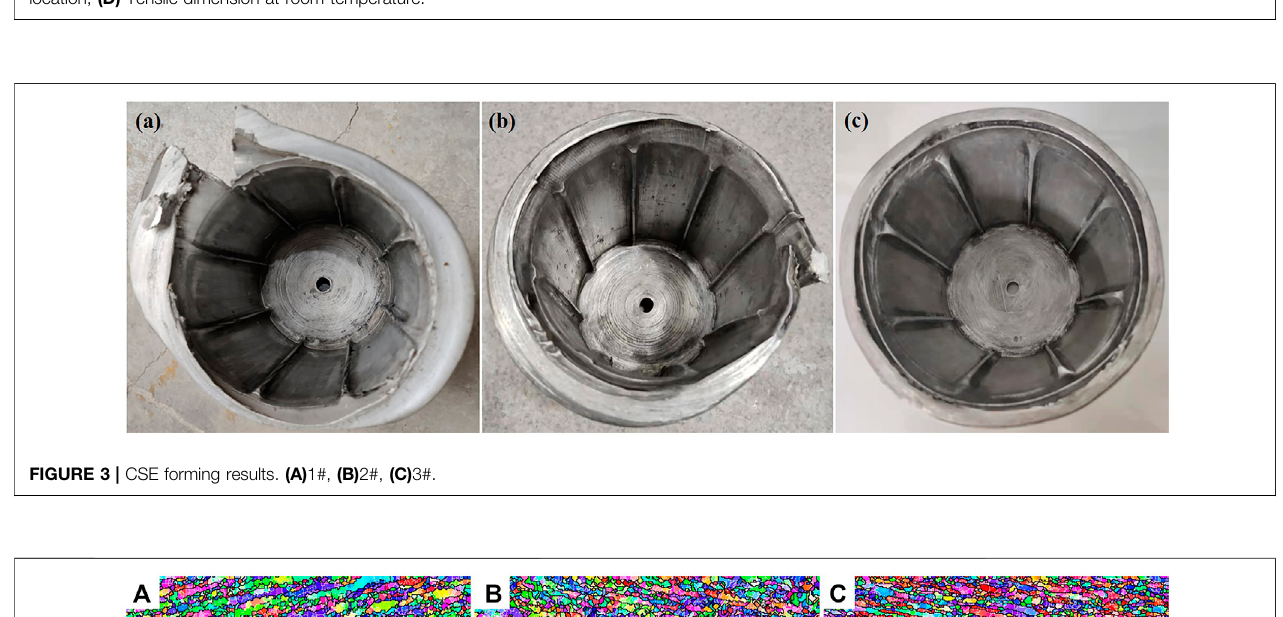
FIGURE 2 | CSE forming schematic diagram and tensile specimen size at room temperature. (A) CSE forming schematic, (B) CSE forming result, (C) Sampling location, (D) Tensile dimension at room temperature.